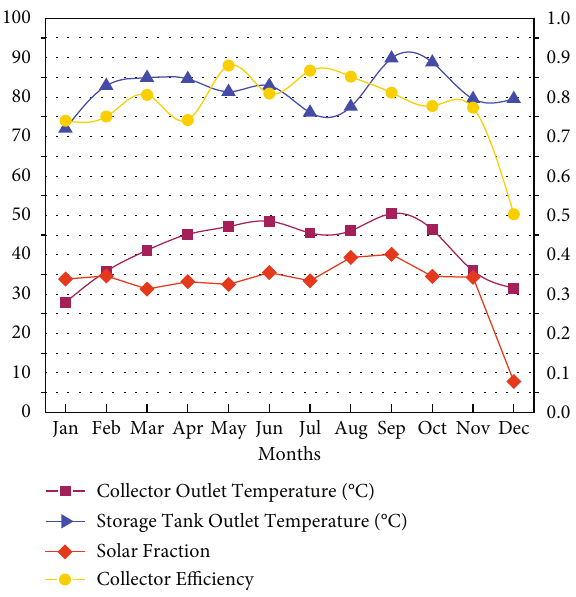
Figure 8: Flat-plate output curves for system e ffi ciency